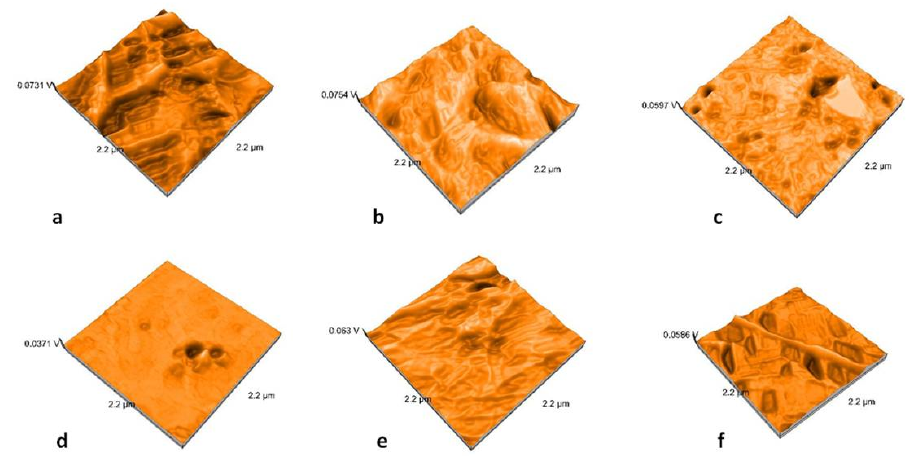
Figure 11. AFM images of the glazed samples: ( a ) LDS-P-G-HT, ( b ) LDS-P-G-MT, ( c ) LDS-M-G-MT, ( d ) ZLS-P-G-HT, ( e ) ZLS-P-G-MT, and ( f ) ZLS-M-G-MT.